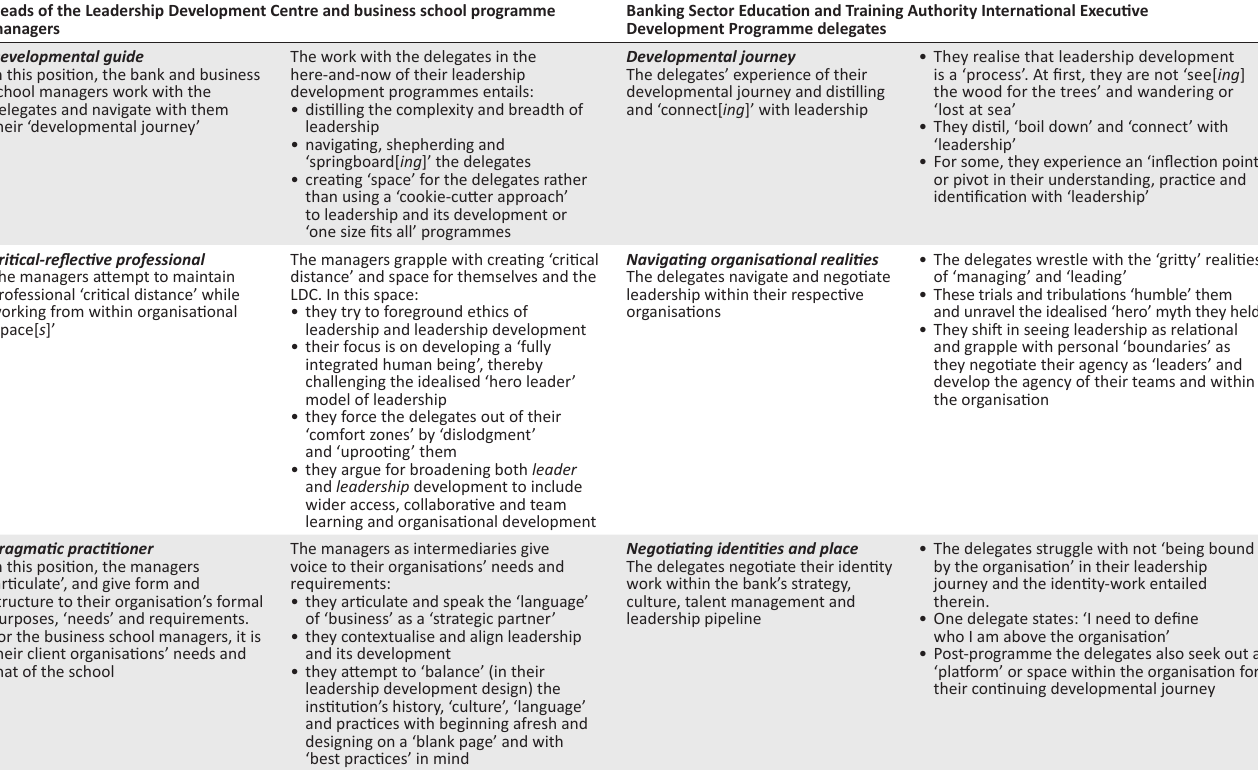
TABLE 3: Evolving